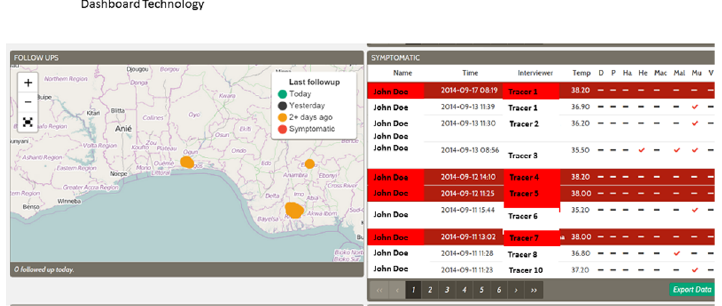
Fig 3. Screen shot of web dashboard built with python and git hub using PLSQL